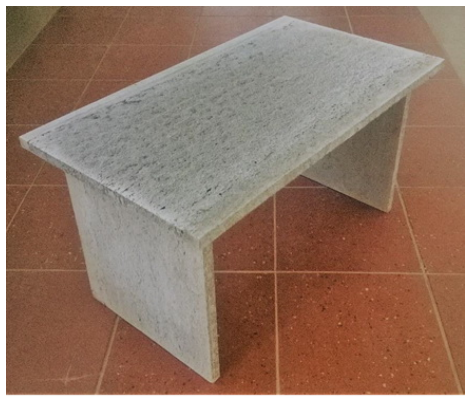
Figure 1. The coffee table